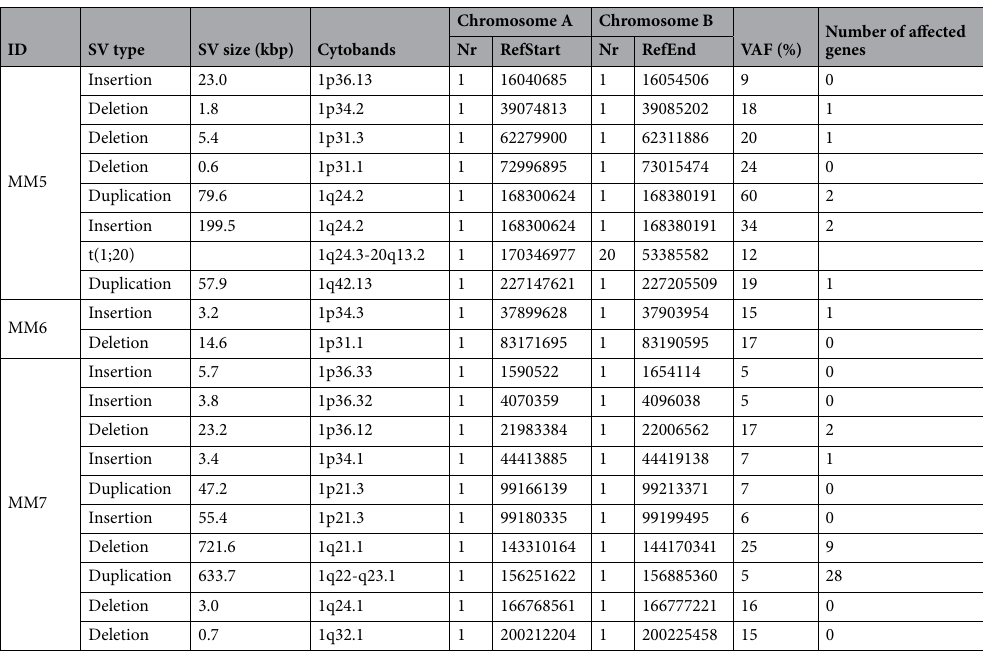
Table 2. SVs on chromosome 1 in enrolled EMM and MM patients. intra-chrom intrachromosomal rearrangements, VAF variant allele frequency, SVs structural